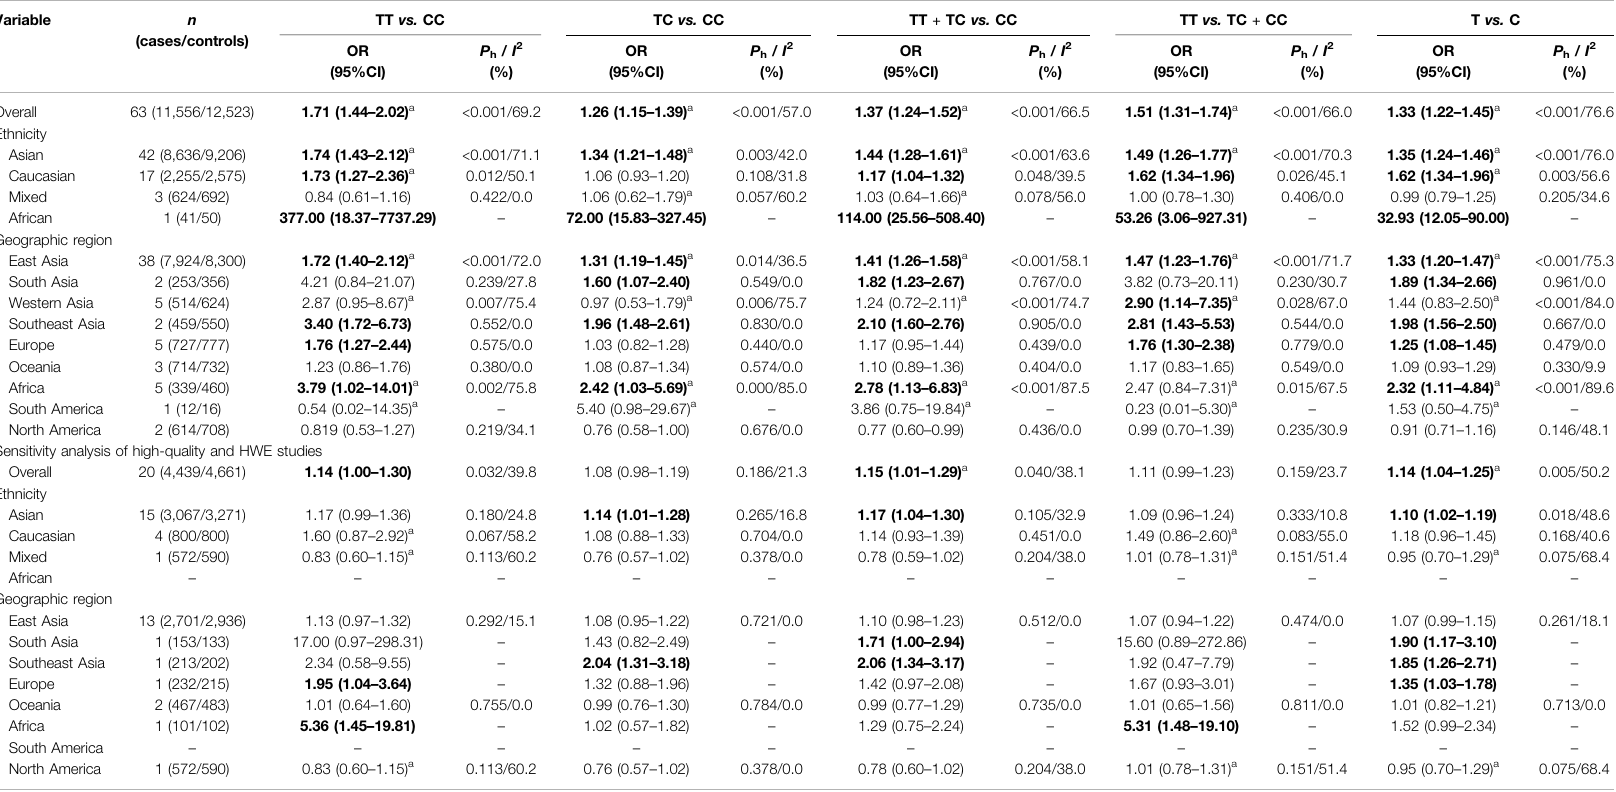
TABLE 5 | Pooled results and sensitivity analysis of the association between MTHFR C677T polymorphism and essential hypertension. The meaning of bold is in different subgroups, there are statistically signi fi cant gene models. In other words, it is the genetic model associated with EH.